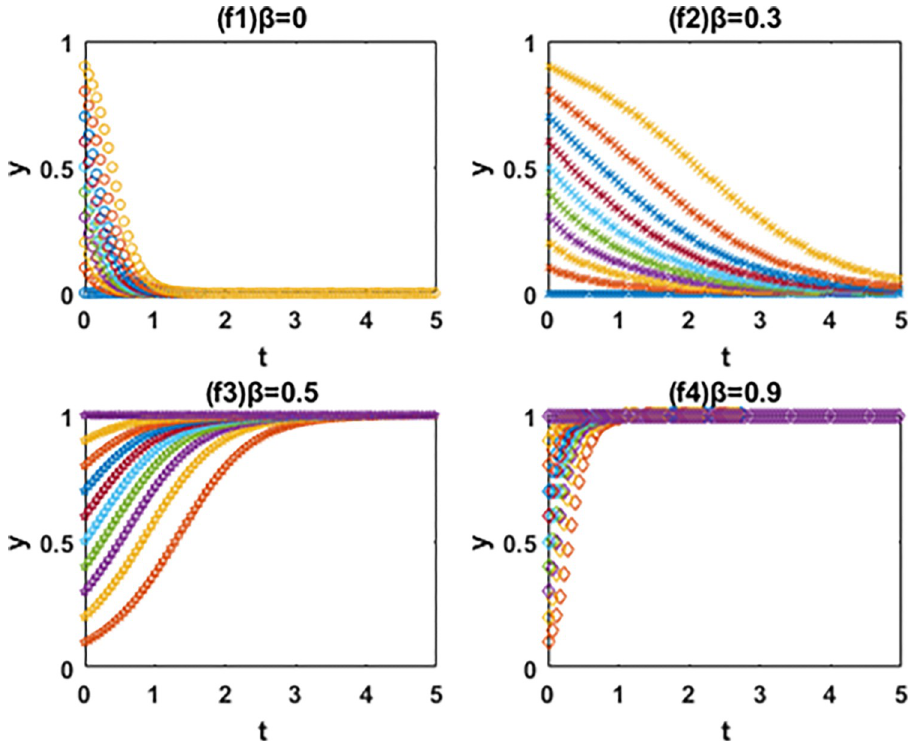
Fig 11. Effects of β on the path selection of the follower enterprise